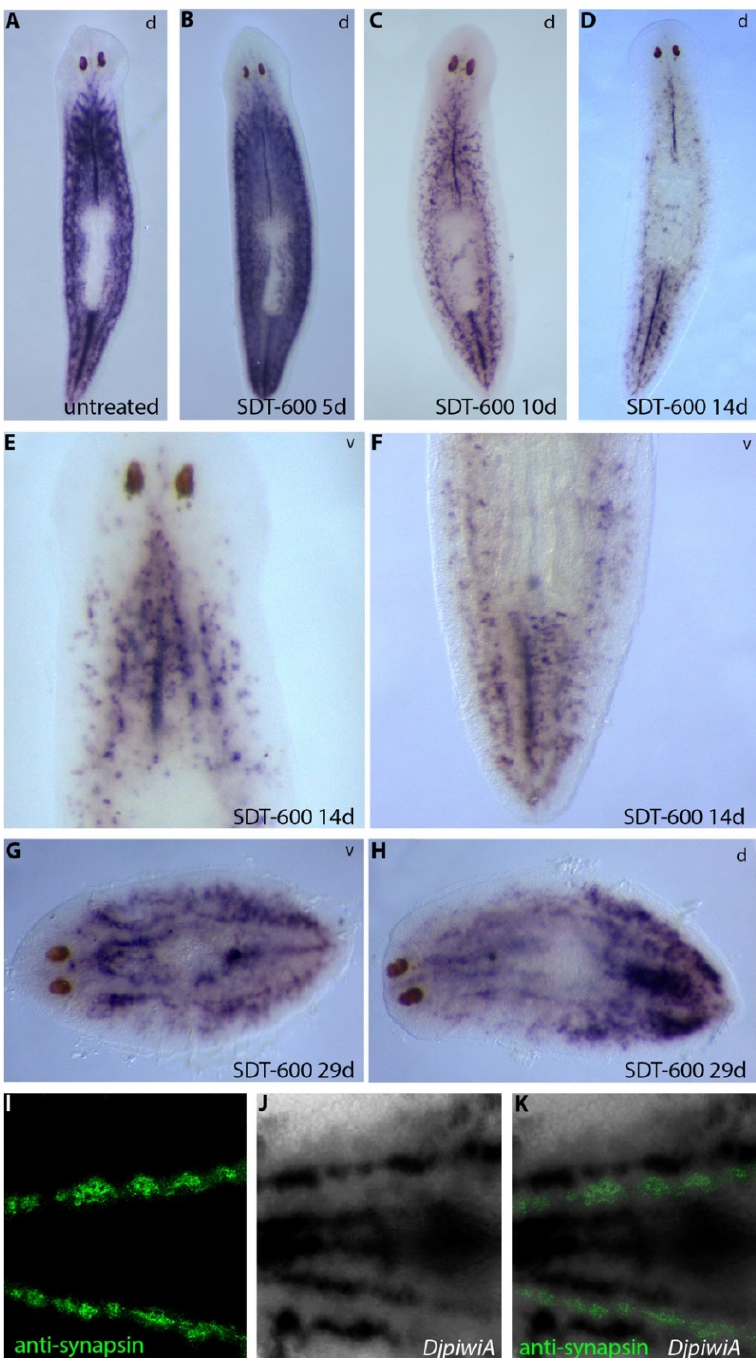
Figure 2. DjpiwiA expression visualized by whole-mount in situ hybridization in intact SDT-600 animals and untreated controls. ( A ) Representative image of a control untreated animal in dorsal (d) view. ( B ) Representative image of an SDT-600 animal 5 days after treatment. ( C ) Representative image of an SDT-600 animal 10 days after treatment in dorsal (d) view. ( D – F ) Representative images of an SDT-600 animal 14 days after treatment in dorsal (d) and ventral (v) views. ( G , H ) Representative images of an SDT-600 animal 29 days after treatment in dorsal (d) and ventral (v) views. ( I – K ) Post-hybridization immunostaining with anti-synapsin antibody that reveals proximity between anti-synapsin-positive ventral nerve cords (green) and DjpiwiA hybridization signal (dark brown). Scale bar corresponds to 500 µ m in ( A – D ), 110 µ m in ( E – F ), 200 µ m in ( G – H ), and 80 µ m in ( I – K